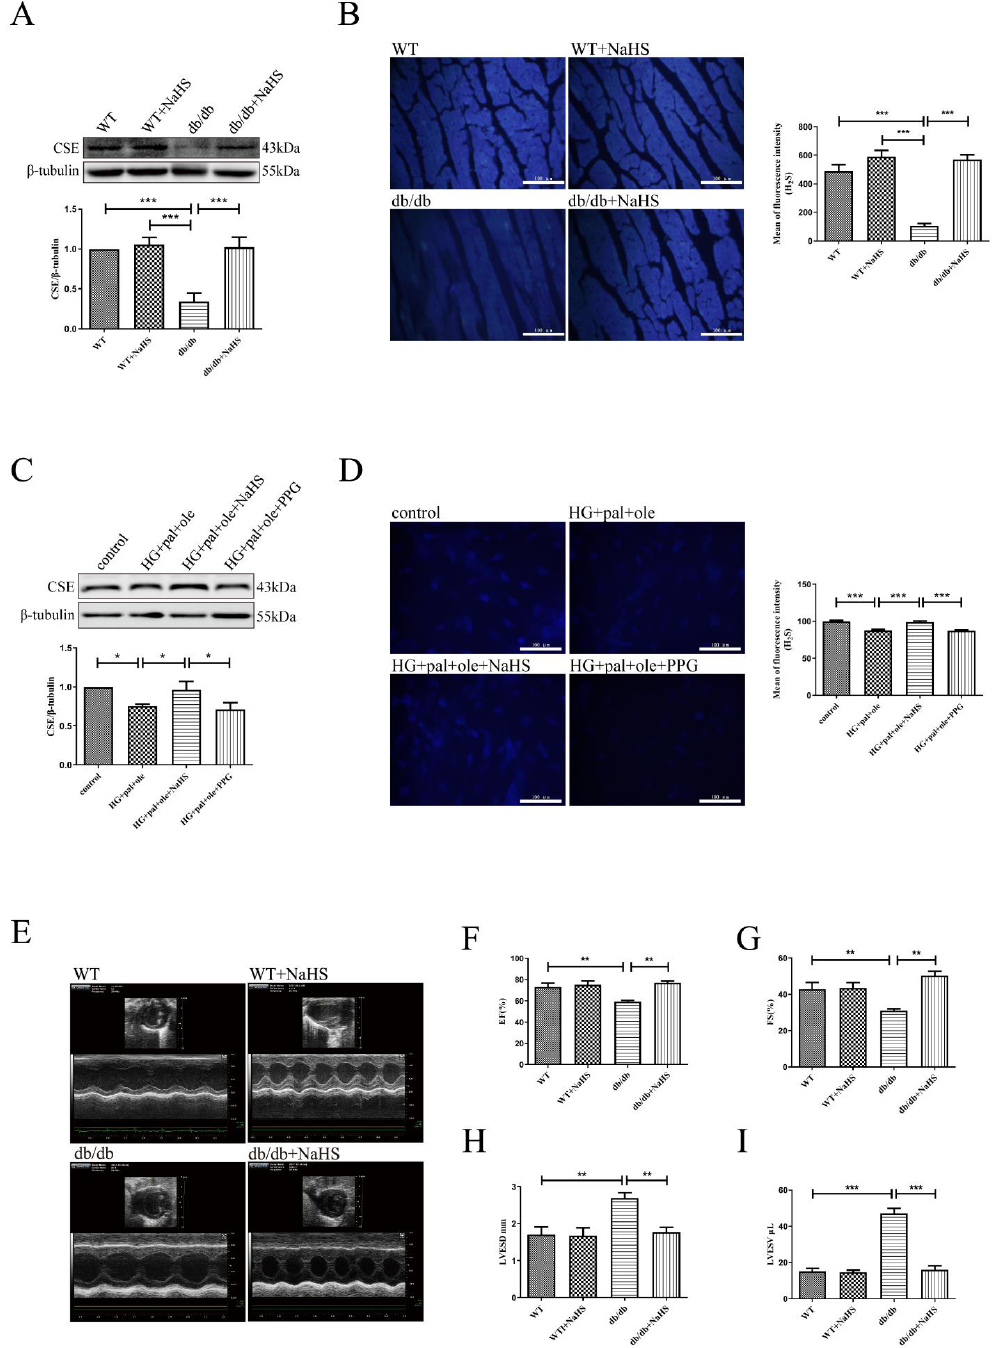
Figure 1. Exogenous H 2 S ameliorated cardiac function in db/db mice. ( A ) CSE expression was detected by Western blot analysis in the cardiac tissues ( n = 5). Scale bar: 100 µ m. ( B ) In cardiac tissues of db/db mice, H 2 S content was detected by 7-azido-4-methylcoumarin ( n = 5). ( C ) CSE expression was detected by Western blot analysis in the NRCMs ( n = 5). ( D ) In NRCMs, H 2 S content was detected by 7-azido-4-methylcoumarin ( n = 6). Scale bar: 100 µ m. ( E ) Representative M-mode echocardiographic of mice hearts. ( F ) Quantitative analysis of Ejection fraction by